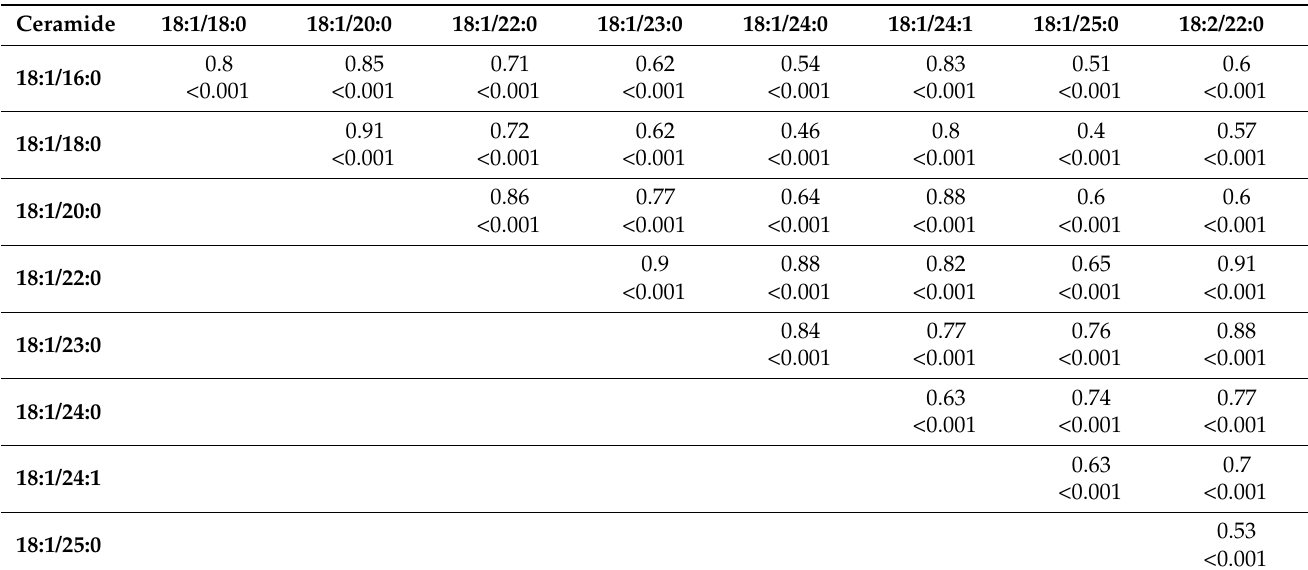
Table 2. Correlation between ceramides .